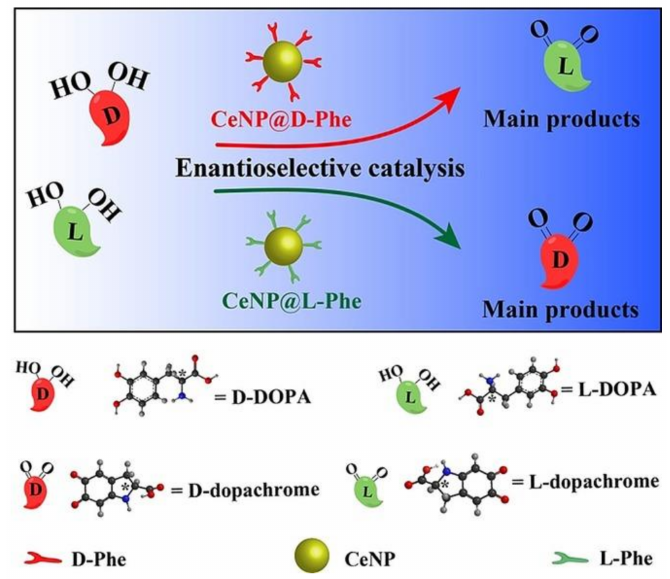
Figure 10. Stereoselective catalytic oxidation of DOPA by phenylalanine (Phe)-modified ceria NPs. The catalyst with D-Phe oxidized L-DOPA into L-dopachrome more effectively. Conversely, the catalyst with L-Phe oxidized D-DOPA into D-dopachrome more effectively. Reproduced with permission from [103], Copyright © 2021 Wiley-VCH Verlag GmbH & Co. KGaA,